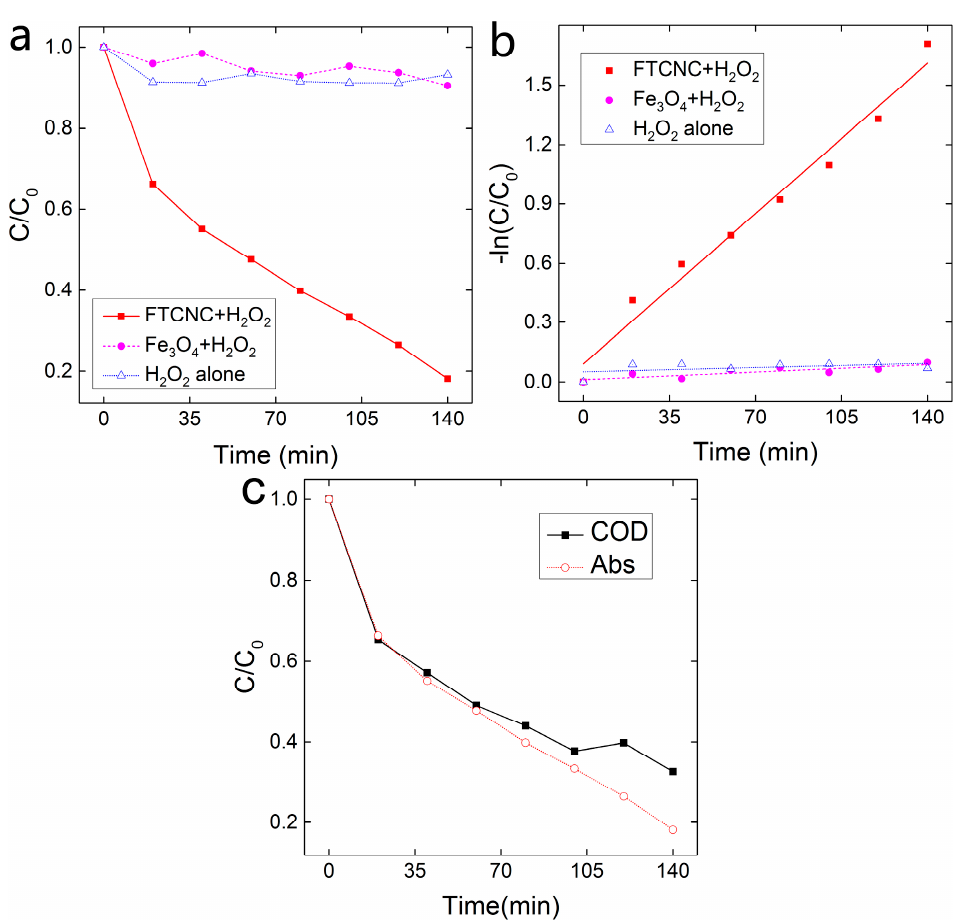
Figure 4. Catalytic activity of FTCNCs. ( a ) Decoloration efficiency; ( b ) kinetics analyses; ( c ) COD (chemical oxygen demanding) removal.